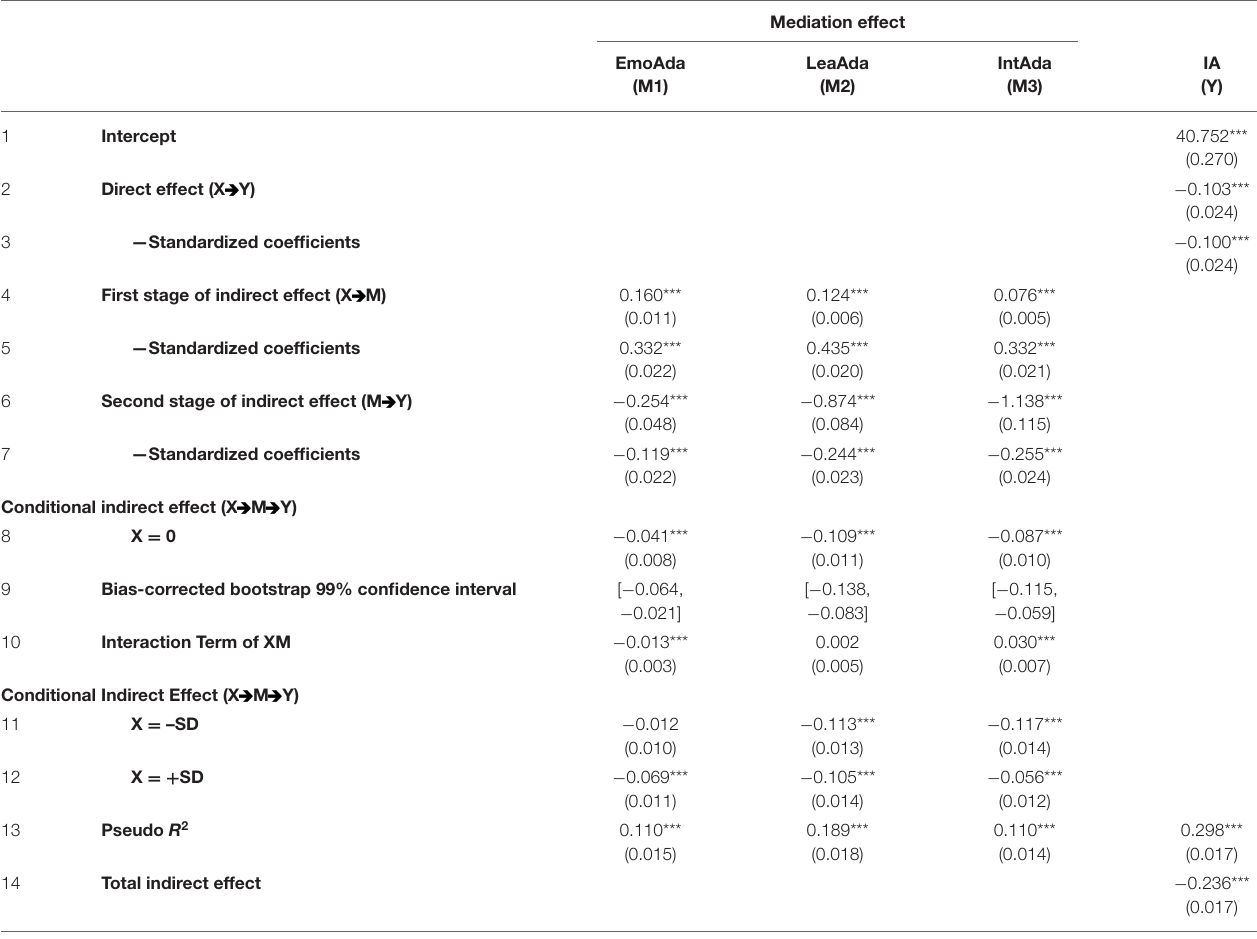
TABLE 3 | The output of multiple mediation model with IDV